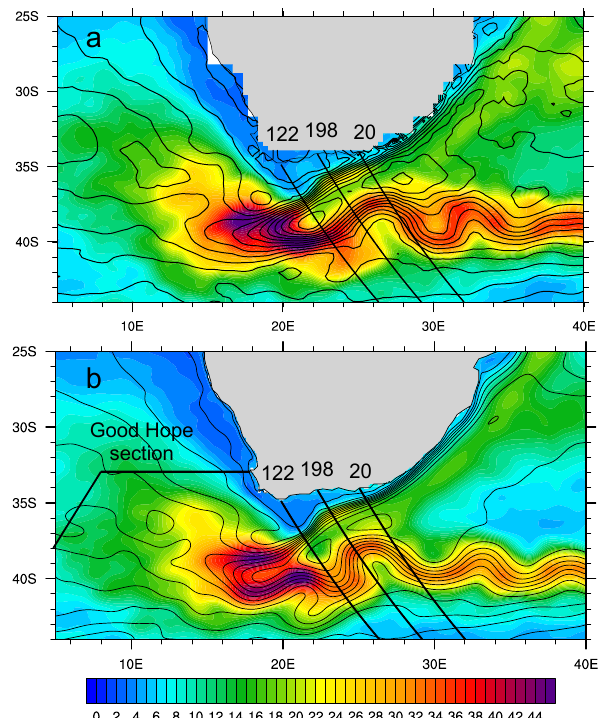
Figure 1. Mean values of absolute dynamic topography (contours) and its standard deviation (color, in cm 2 ) with the Topex/Poseidon satellite tracks used for this work. (a) Mapped satellite altimetry product and (b) INALT01 model.